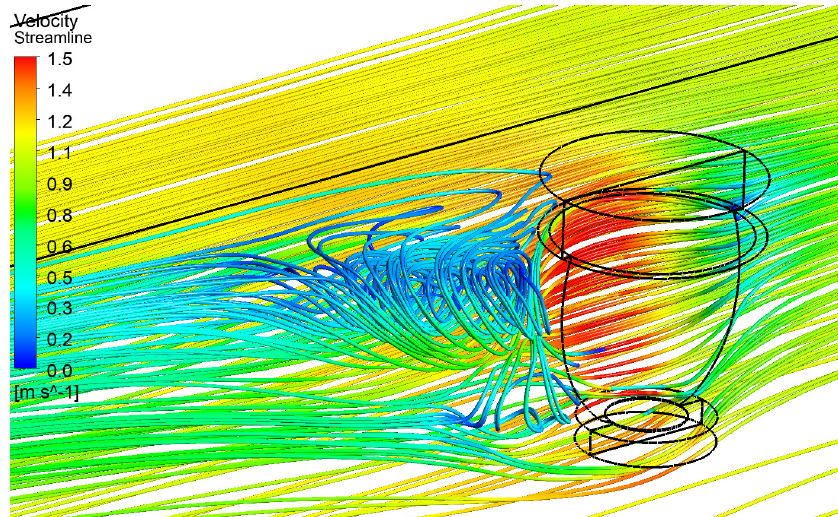
Figure 14. CFD results Re = 7.8 × 10 5 : 3D streamlines for water